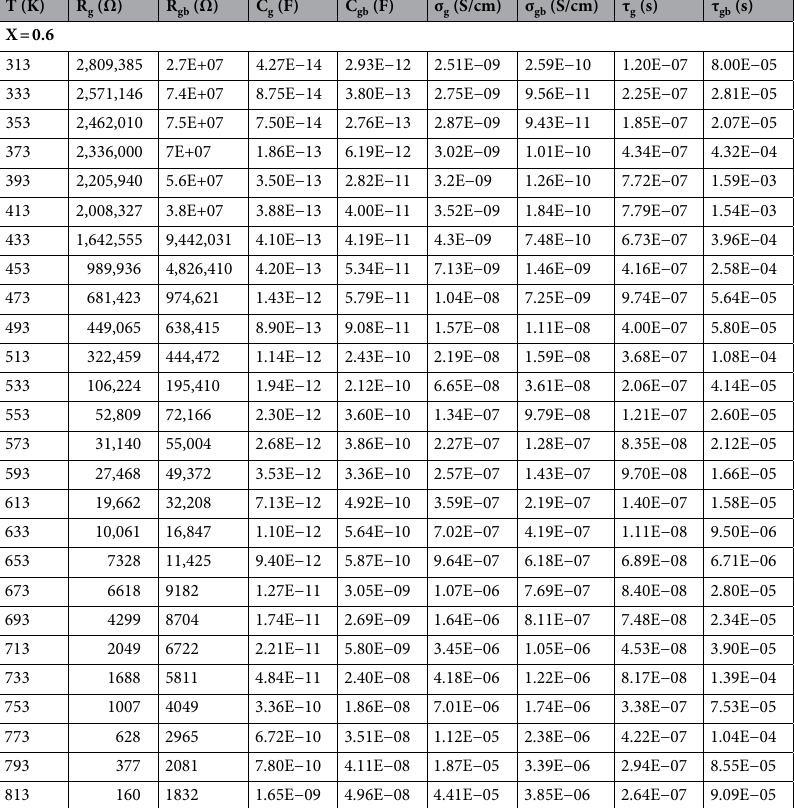
Table 6. Impedance spectroscopy parameters of X = 0.6